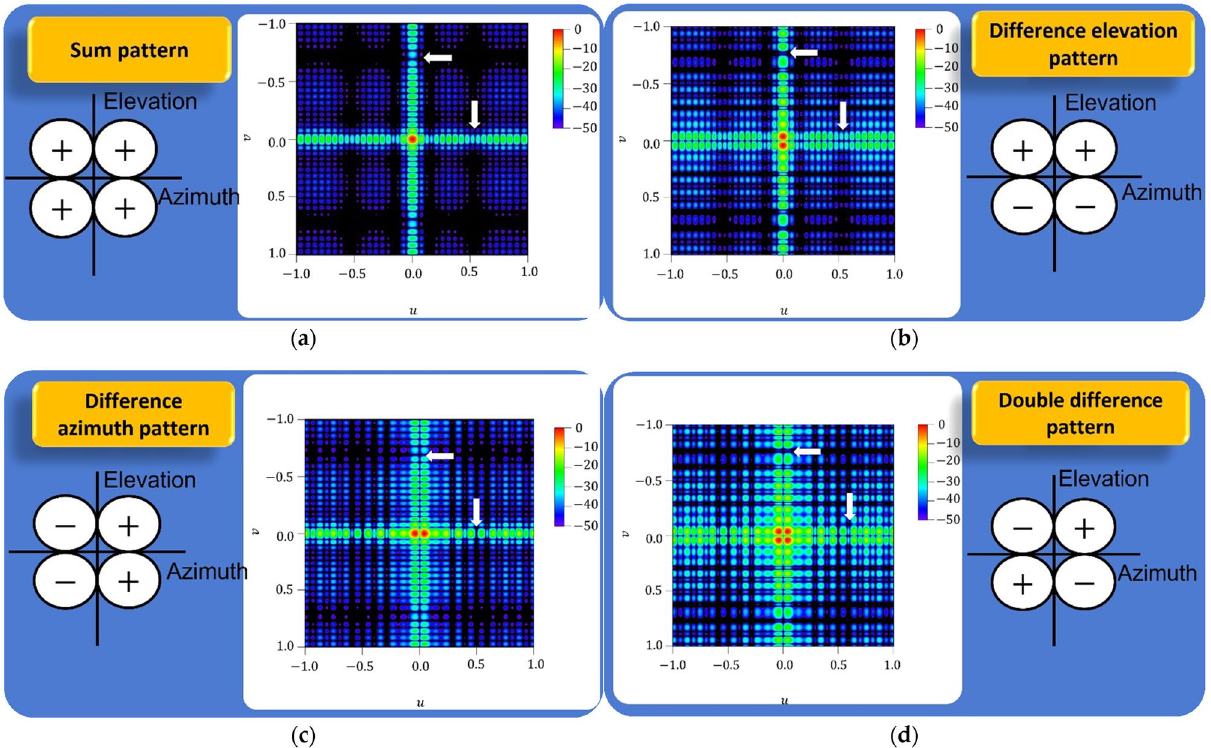
Figure 2. Results for the extension to a planar architecture based on separable distributions. Considering sum/ difference pattern on each axis, four results can be produced: ( a ) sum pattern (sum–sum combination), ( b ) elevation difference pattern (difference–sum combination), (c) Azimuth difference pattern (sum–difference combination), (d) double difference pattern (difference–difference combination). In all the cases, the 3-D representation of the far-field pattern uses is expressed in terms of u = sin θ cos ϕ and v = sin θ sin ϕ . The white arrows included on each tridimensional pattern indicate the obtained deep nulls on each case. The relative phase response in each quadrant is included on each